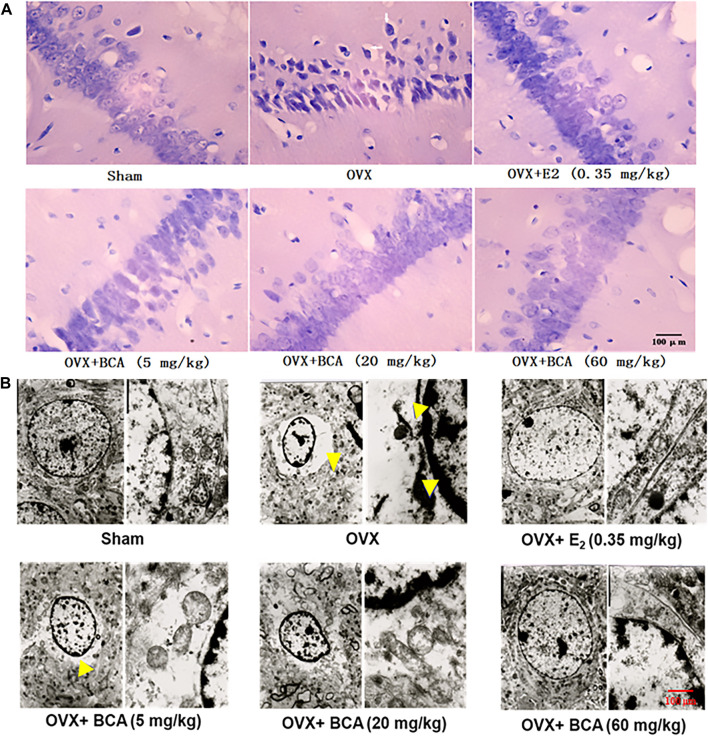
The effects of BCA on morphology and structure of hippocampal neurons in the OVX rats. (A) HE staining of hippocampal CA1 subregions. Pyramidal cells in CA1 were extensively damaged, as indicated by reduced cell volume and nuclear chromatin condensation (indicated by yellow arrows) in the OVX rats. (B) Ultrastructure changes in hippocampal CA1 via electron microscopy. The disappearance of cell membranes, multiple vacuoles around nuclei and nuclear chromatin inside the nuclear membrane were observed in the hippocampus of OVX rats. These abnormal changes in neurons were improved following treatment with E2 or BCA.